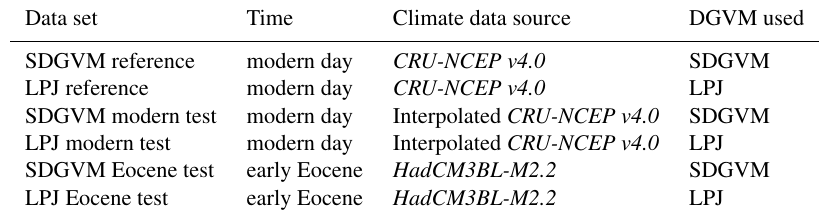
Table 1. Summary of reference and test data sets used combining data from dynamic global vegetation models SDGVM (Woodward et al., 1995; Beerling and Woodward, 2001) and LPJ (Wania et al., 2009) with climate data from CRU-NCEP v4.0 (Wei et al., 2014) for the modern day, and HadCM3BL-M2.2 (Valdes et al., 2017) for the early Eocene. Data set